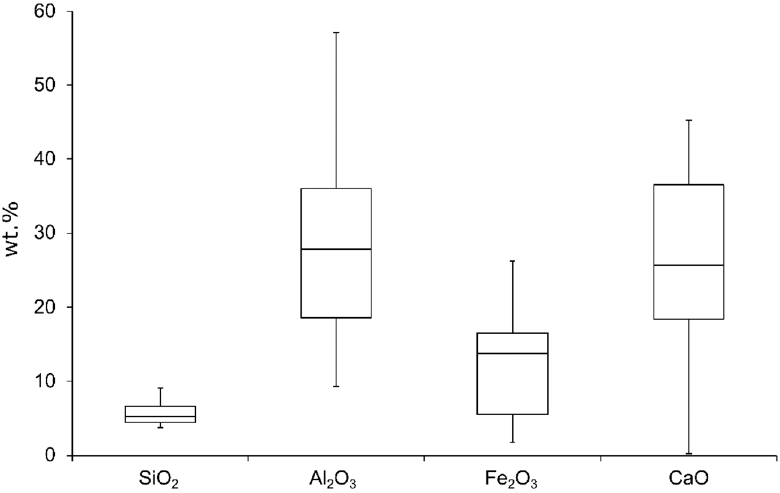
Figure 6. Box plot showing major oxide compositions (wt.%) of Vitulano bauxites. The most abundant trace elements are Zr (med = 257 ppm), Cr (med = 230 ppm), Sr (med = 157 ppm), and V (med = 118 ppm), while further trace elements, such as Sc (med = 30 ppm), Ba (med = 39 ppm), Y (med = 44 ppm), Co (med = 20.5 ppm) Ni (med = 120 ppm), Cu (med = 30 ppm) (med = 118 ppm), Zn (med = 80 ppm), Ga (med = 28 ppm), Nb (med = 26 ppm), Th (med = 41 ppm), and Th (med = 20.9 ppm), show lower concentrations. High variability was observed for Cr (IQR = 190) and Zr (IQR = 158), while the rest of the trace elements, such as Ni (IQR = 80), V (IQR = 68.5), Zn (IQR = 52.5), Sr (IQR = 45), Pb (IQR = 32), Ba (IQR = 30.5), Y (IQR = 28), Sc (IQR = 19), Cu (IQR = 15), and Nb (IQR = 12.5) show from moderate to low variability (Figure 7). It has to be noted that the sample CS2 shows high Sr value (1520 ppm), and this can be explained by the presence of an Sr-rich calcite in the matrix or by isomorphogenic substitution and enrichment in SrCO 3 .